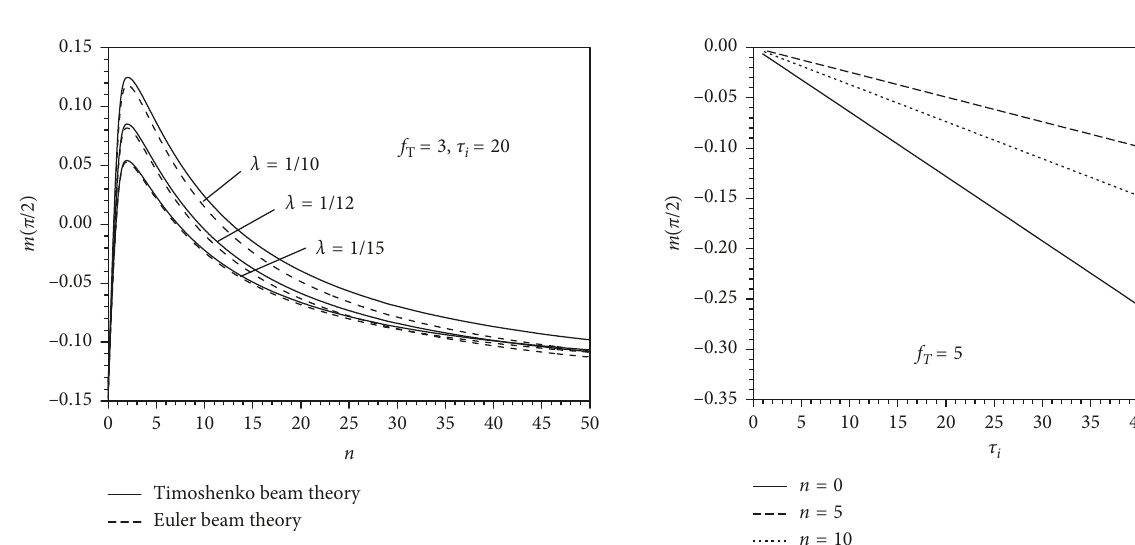
Figure 6: Variation of m ( λ (cid:31)